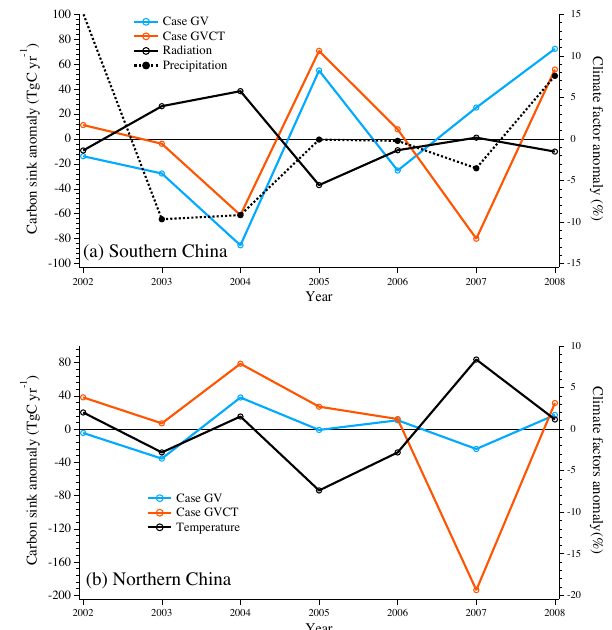
Figure 5. Inter-annual variations of the posterior fluxes and climate factors in (a) southern China and (b) northern